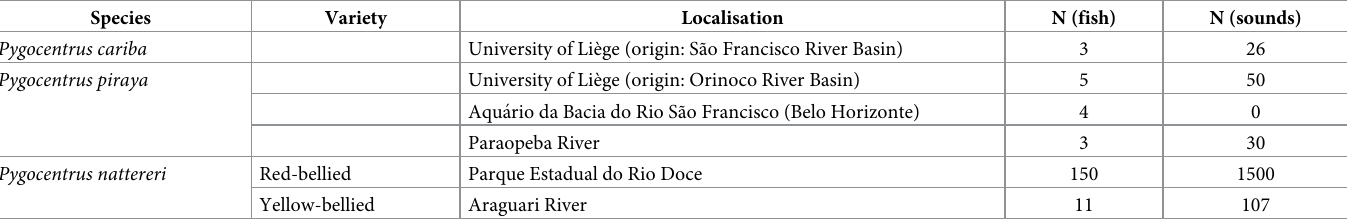
Table 1. Specimens recorded in this